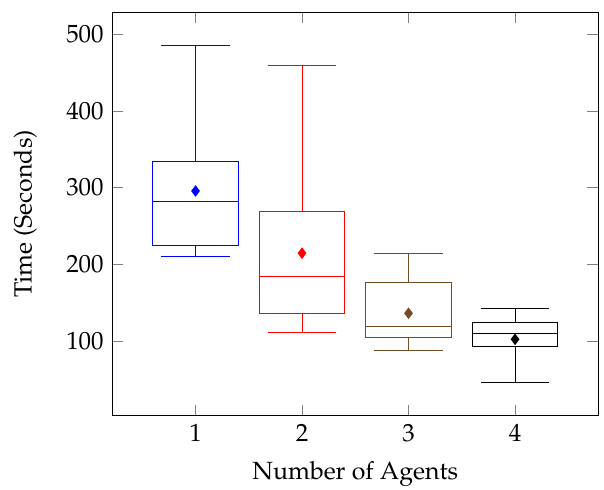
Figure 13. Number of Agents vs. Time (Seconds)-All Target Locations in Test Environment One.